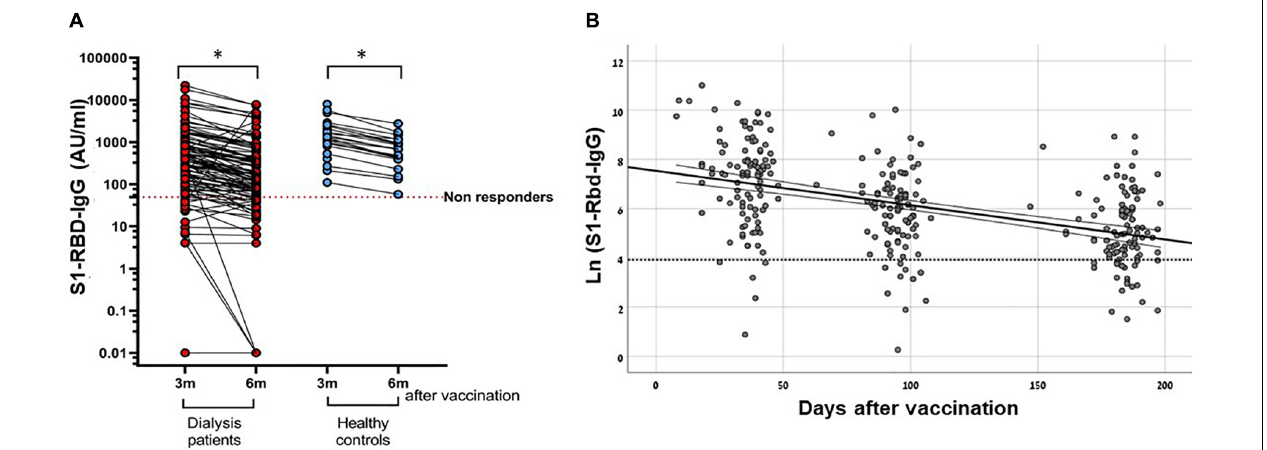
FIGURE 2 | Antibody decay rate in hemodialysis patients following BNT162b2 vaccination. (A) S1-RBD-IgG level 3- and 6-months following 2nd dose of BNT162b2 vaccine in HD Patients vs healthy controls. Results refer to HD group ( n = 104) and control group ( n = 21). * P -value < 0.001 using multivariate repeated ANOVA test. (B) S1-RBD antibody decay rate at 1-, 3- and 6- months following the 2nd dose of BNT162b2 vaccine in HD Patients. A regression line was adjusted to the ln-transformed antibody level. Time to Ab level decay below 50 AU/ml - 259.54 days (95% CI 212.98 to 332.17). Results refer to HD group ( n = 104).